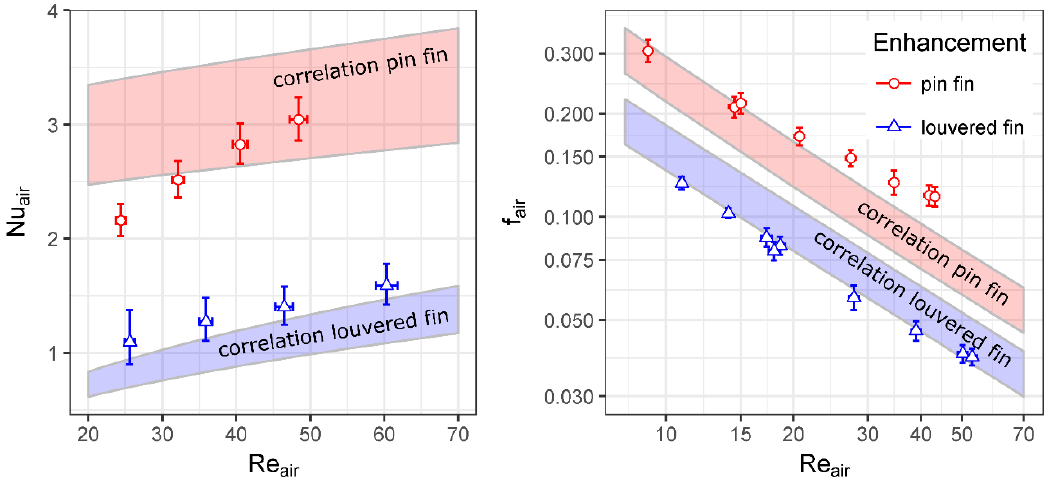
Figure 11. Thermo-hydraulic performance in non-dimensional form; Nusselt number Nu st ( left ) and Fanning friction factor f st ( right ) versus Reynolds number Re st ; Ribbons represent correlated data for pin fins [22] and louvered fins [23]; error bars for expanded uncertainty.